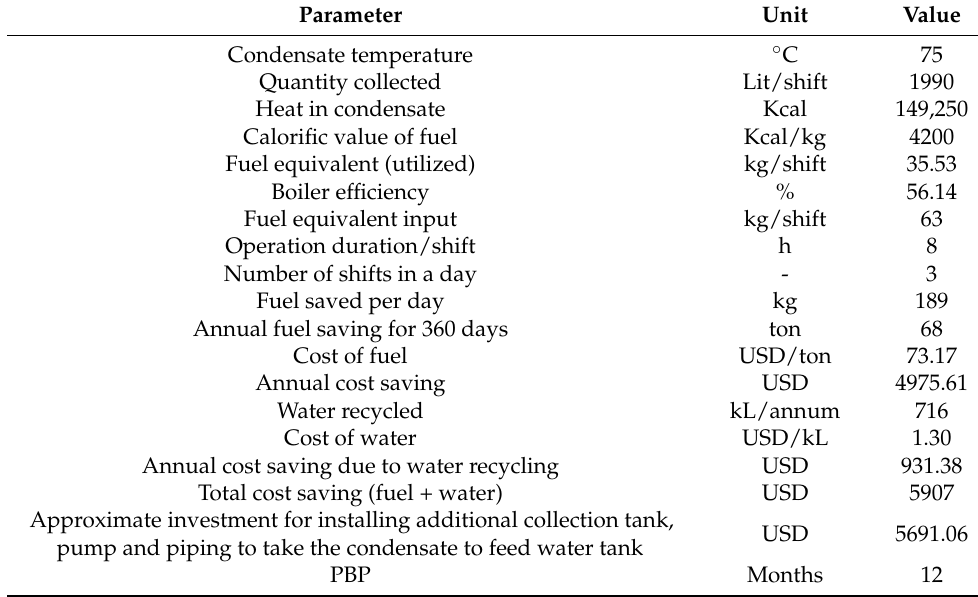
Table 10. Energy saving opportunity in boiler through condensate